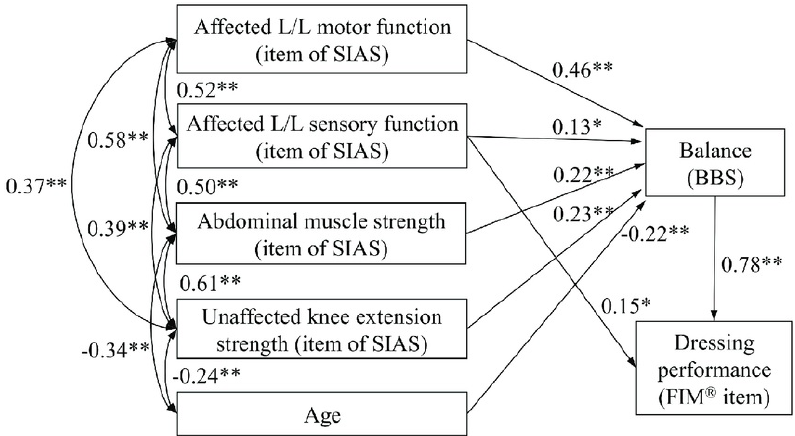
Fig. 2 The revised model path